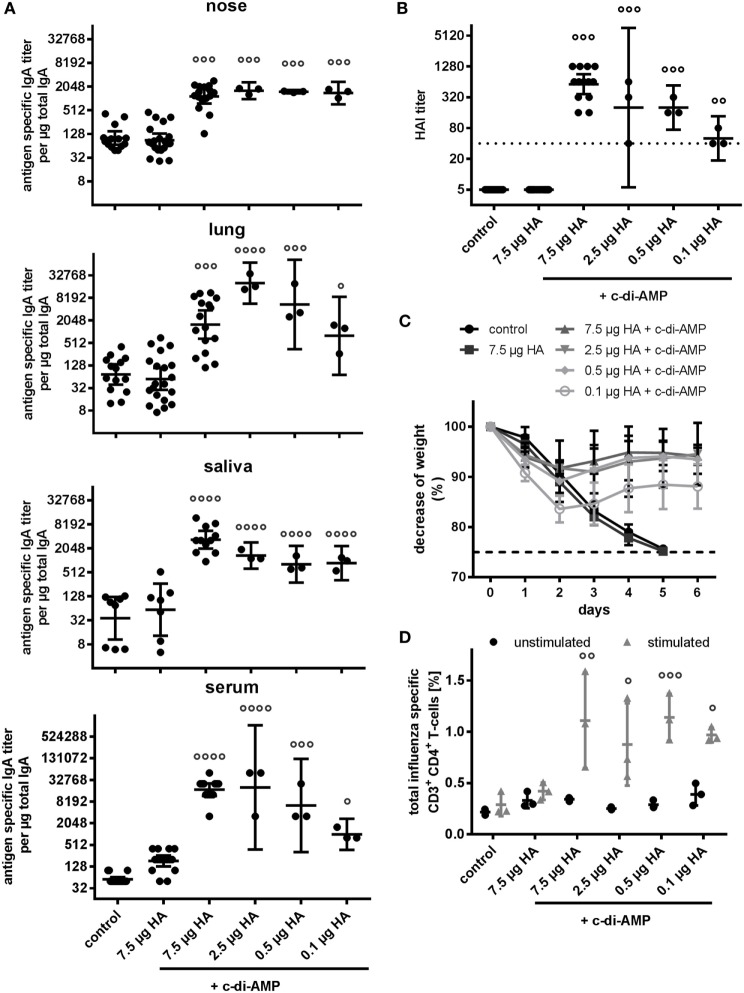
Dose sparing. Groups of three BALB/c mice were immunized intranasally with PBS (control) or with two doses (21 days apart) of H5N1 virosomes [7.5, 2.5, 0.5, or 0.1 µg hemagglutinin (HA)], alone (only 7.5 µg HA) or adjuvanted with cyclic di-adenosine monophosphate (c-di-AMP) (5 µg). (A) Mucosal antibody response. At 21 days after the second immunization, lung and nasal washes, as well as samples of saliva and serum were collected. Total and antigen-specific IgA was measured by ELISA. The geometric means with 95% CI are shown of the endpoint titer of antigen-specific IgA per μg total IgA in the case of the lavages, and the endpoint titer of antigen-specific IgA in the case of serum. Each symbol represents one animal. Statistically significant differences from the antigen alone group measured by one-way ANOVA with Dunnett’s post hoc test of log2 normalized data is shown by asterisks (*p < 0.05, **p < 0.01, ***p < 0.001, ****p < 0.0001). (B) Correlates of protection. At 21 days after the second immunization, blood was sampled and sera obtained. The hemagglutination inhibition (HAI) titers against homologous virosomes were measured and presented as one symbol per animal. The lines represent the geometric mean of the titers with 95% CI. Negative samples were assigned a value of 5 for calculation purposes. The dotted line represents the protective HAI titer of 40. Statistically significant differences from the antigen alone group measured by one-way ANOVA with Dunnett’s post hoc test of log2 normalized data is shown by circles (°p < 0.05, °°p < 0.01, °°°p < 0.001, °°°°p < 0.0001). (C) Virus Challenge. Four weeks after the second immunization, mice (PBS and 7.5 µg HA + c-di-AMP 11 animals, antigen alone and 2.5 µg HA, 0.5 µg HA, and 0.1 µg HA + c-di-AMP 9 animals) were intranasally challenged with 2 × 103 ffu of NIBRG-14 and the mean percentage changes in body weight (± SD) were calculated. Weight data from one PBS animal that did not show any clinical symptoms was excluded. According to local regulations, animals showing more than 25% weight loss (dotted line) were euthanized. (D) T cell quality. At 21 days after the second immunization, spleen cells were harvested, restimulated with homologous H5N1 virosomes, intracellularly stained for Th cytokines (IFN-γ, IL-2, TNF-α, IL-4, and IL-17), and analyzed by flow cytometry. All CD4+ cells producing at least one of the measured cytokines were summed to quantify the frequency of influenza virus-specific Th cells. The mean ± SD is shown with each symbol representing one animal. Statistically significant differences from the antigen alone group measured by two-way ANOVA with Dunnett’s post hoc test are shown by circles (°p < 0.05, °°p < 0.01, °°°p < 0.001, °°°°p < 0.0001).